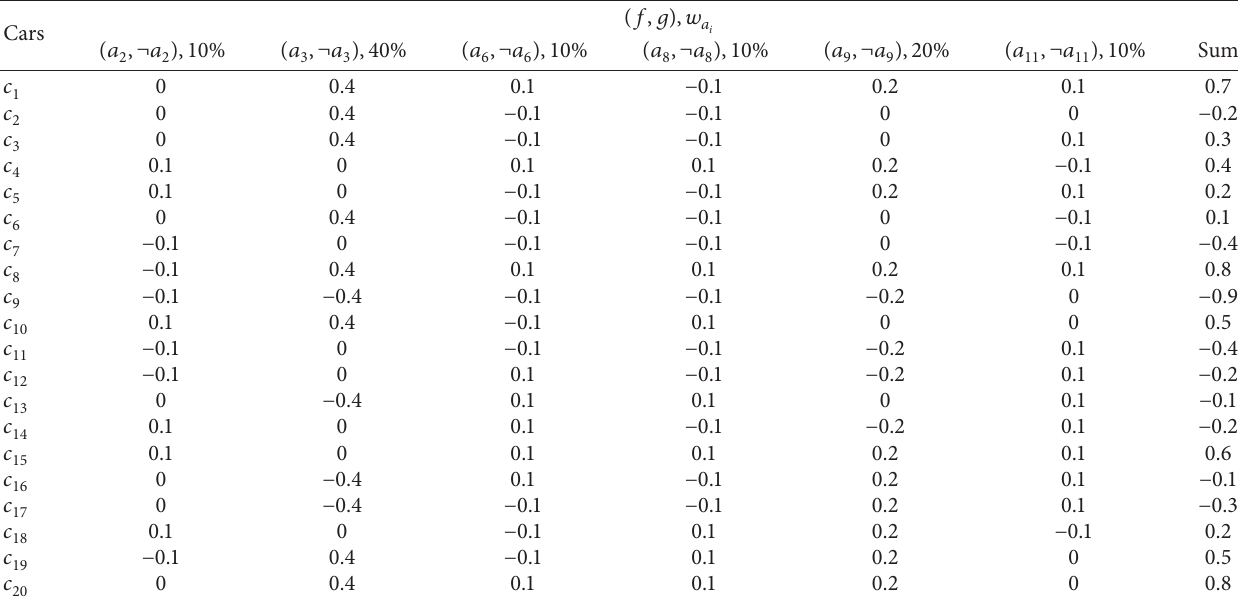
Table 4: Weight values of all components of the favorite bipolar soft sets ( f,g, E ) .